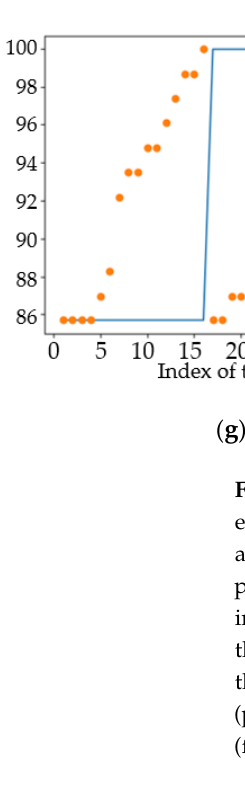
Table 4. Tabular comparison between genetic algorithm-based approaches run over 40 iterations and a sequence of 200 randomly generated stimulus groups.